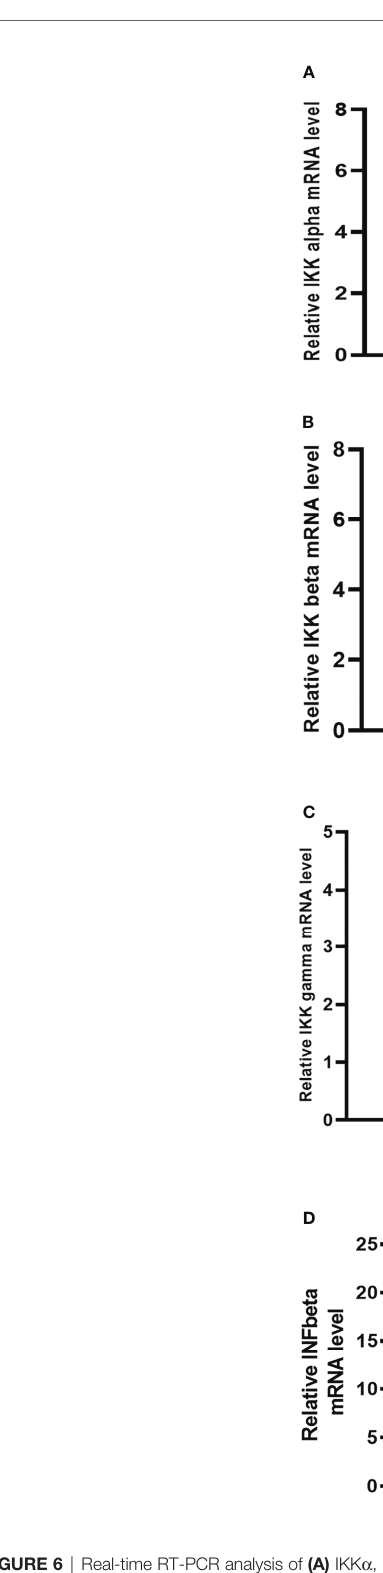
FIGURE 6 | Real-time RT-PCR analysis of (A) IKK a , (B) IKK b , (C) IKK g , (D) IFN- b mRNA levels in infected, healthy and non-infected but in fl ammatory bladder samples. IKK a , IKK b , IKK g and IFN- b mRNA levels were signi fi cantly reduced in diseased bladder samples compared with both healthy and uninfected bladder samples (****p ≤ 0.0001). Plots represent value found in each sample performed in